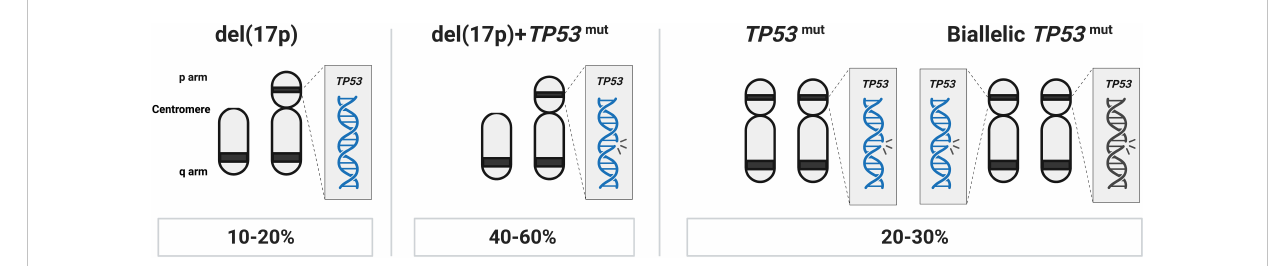
FIGURE 1 TP53 abnormalities in CLL. In approximately 40-60% of cases with TP53 aberrations, del(17p) is found in combination with a TP53 mutation, another 20-30% of cases carry one or more TP53 mutations without del(17p), while in the remaining TP53 aberrant cases (10-20% of patients), only del(17p) is